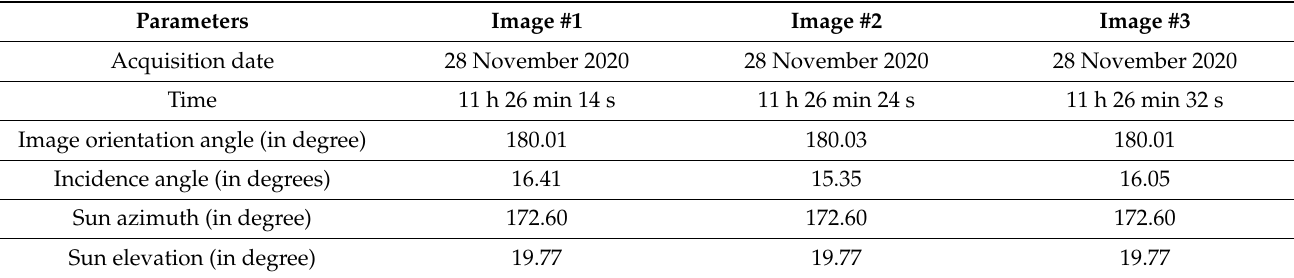
Table 1. Pleiades–1 specificities of the tri–stereo acquisitions over the study site.